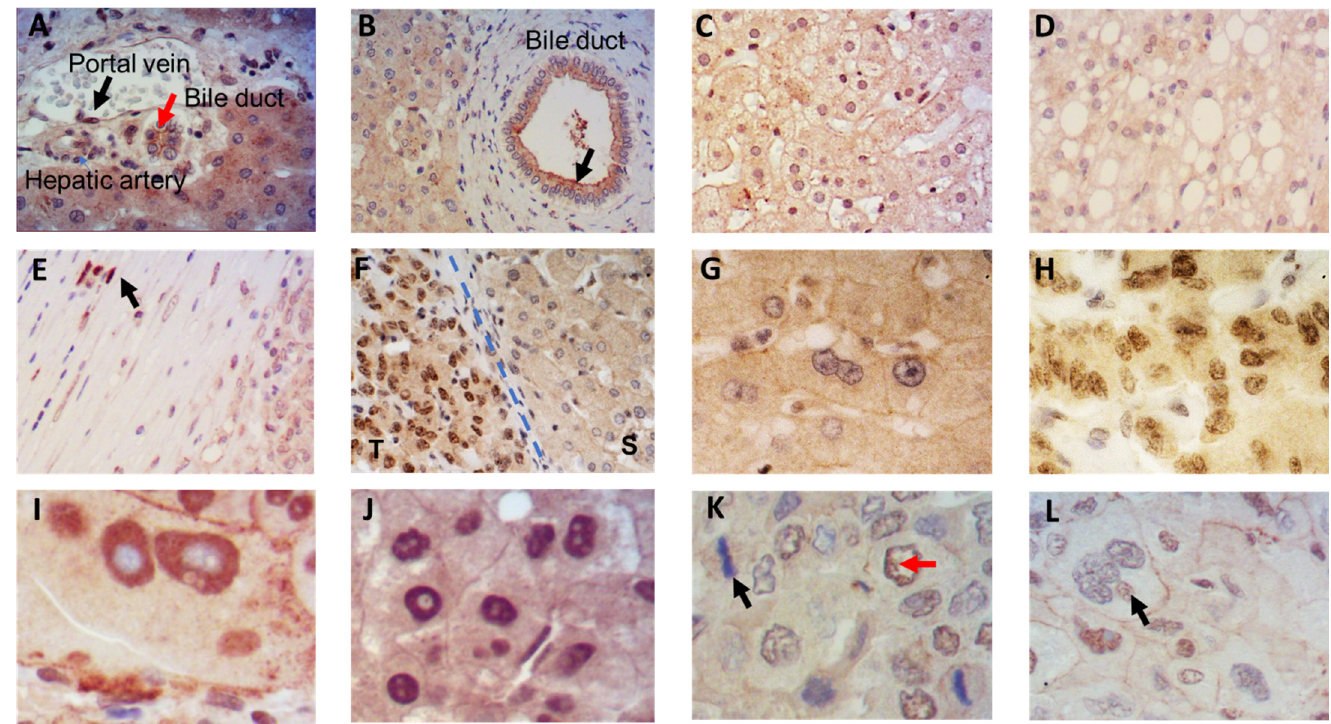
Figure 1. Immunohistochemical staining of IRS-4 in surrounding tissue of the tumoral region ( A – E ) and in the tumors ( F – L ) of human HCC. Paraffin embedded liver biopsies were stained with anti-IRS-4 antibody. T = tumoral region; S = surrounding tissue (A–E 20× magnification and F–L 40× magnification).